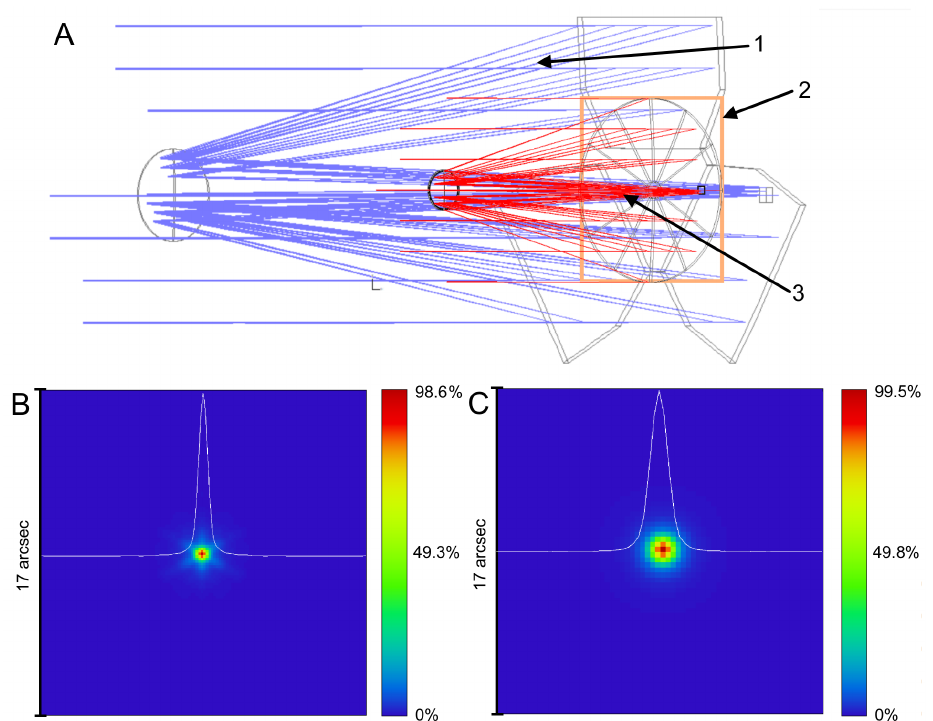
Figure 3. Comparison of a deployable primary mirror case with a monolithic one: ( A ) optical designs compared in scale (1—deployable telescope, 2—1U unit front side, 3—telescope with monolithic mirror), ( B ) PSF with the deployable mirror, ( C ) PSF with a monolithic mirror.